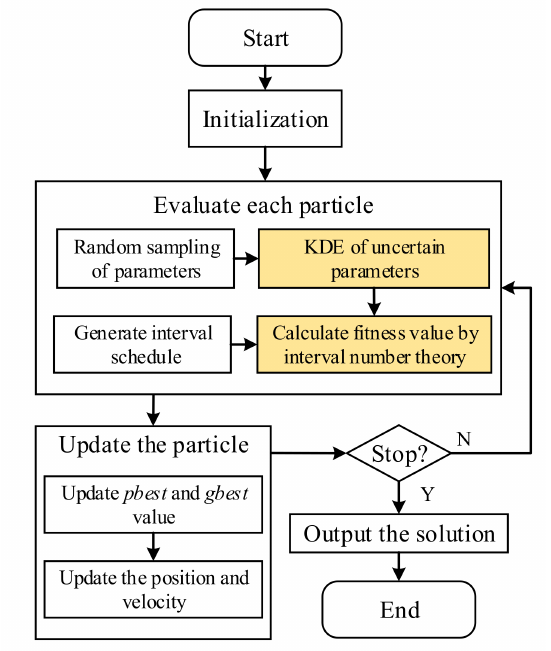
Figure 3. Diagram of the proposed DPSO algorithm